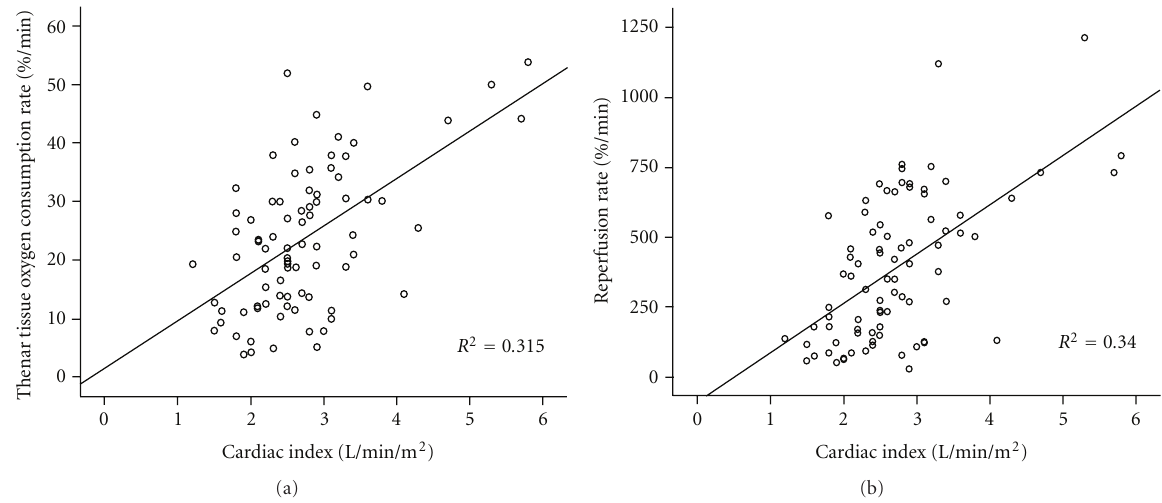
Figure 1: (a) Scattergram of the thenar tissue O 2 consumption rate (%/min) during a 3 min vascular occlusion technique and cardiac index (L/min/m 2 , r = 0 . 56, P < 0 . 001, n = 82) for pooled data. (b) Scattergram of the reperfusion rate (%/min), indicative of the endothelial function after cu ff release following a 3 min vascular occlusion technique and cardiac index (L/min/m 2 , r = 0 . 58, P < 0 . 001, n = 82) for pooled data.